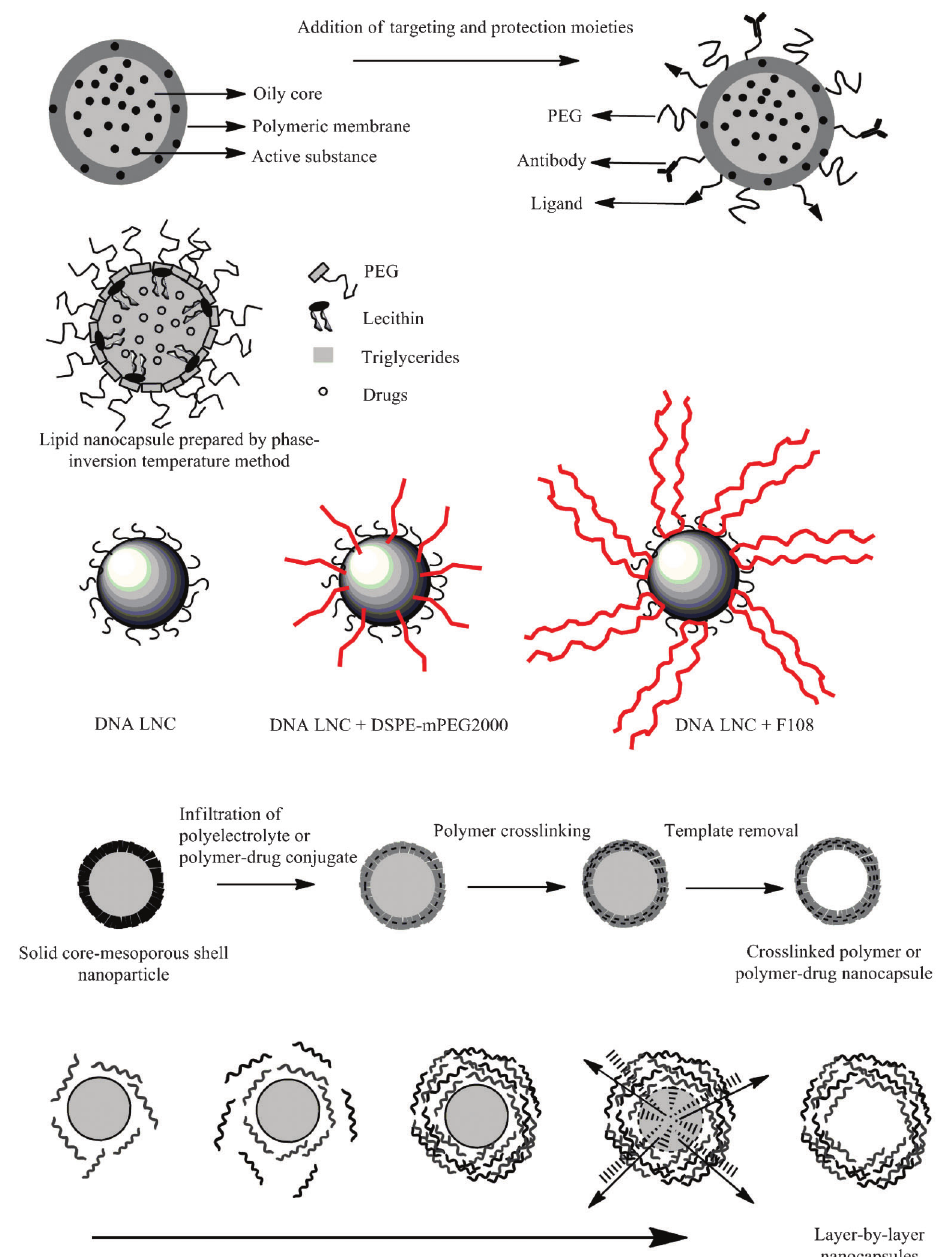
Figure 1. Schematic examples of nanocapsular structures. PEG = polyethylene glycol; LNC = lipid nanocapsules; DESPE- mPEG2000 =